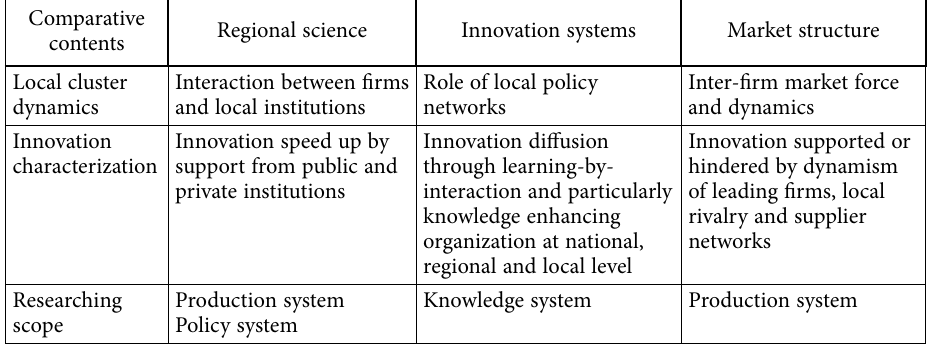
Table 2. Local cluster dynamics and innovation (source: authors’ summary based on